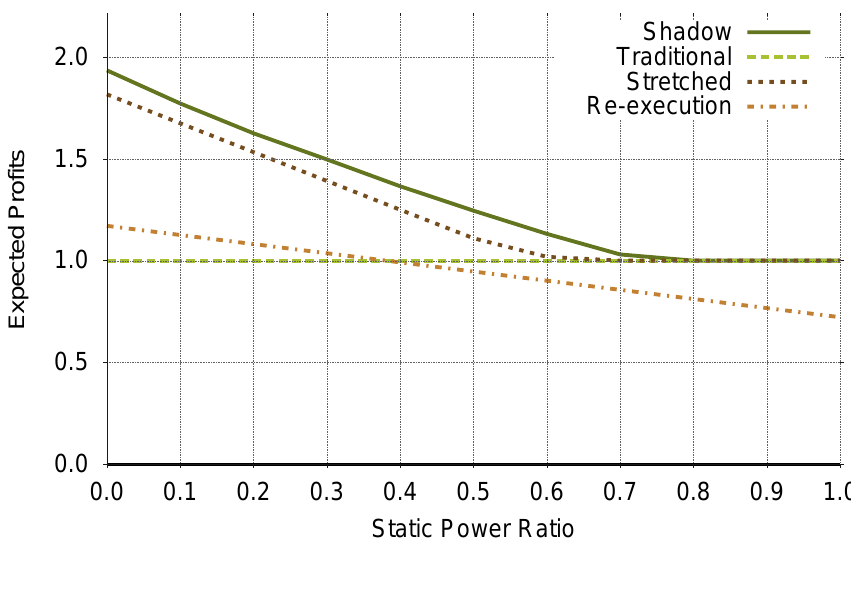
Figure 3. Profit for different static power ratio. MTBF = 5 years, N = 100,000, W = 1 h, t = 1.3 h, t = 2.6 R 1 R 2